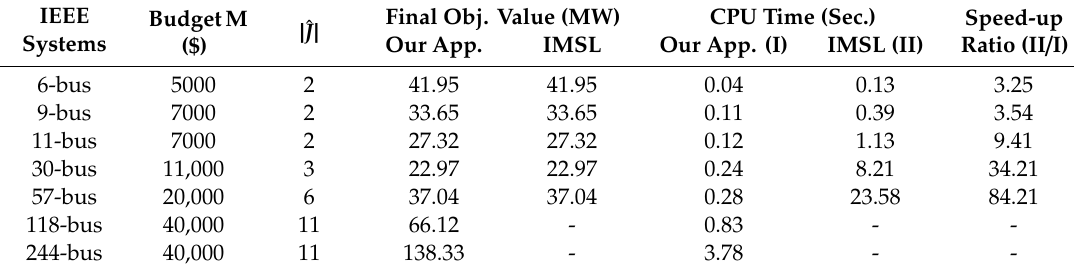
Table 9. Comparisons of the proposed approach with the IMSL numerical libraries for various IEEE